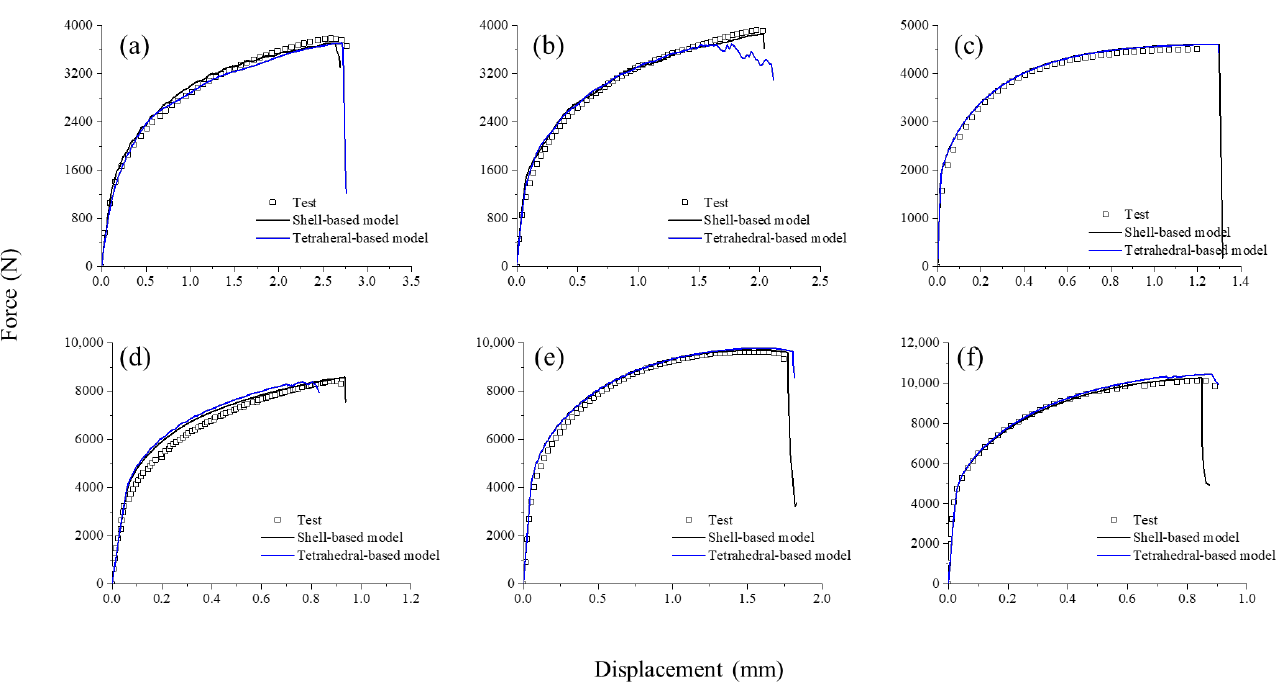
Figure 10. Shell-based model simulation vs. experiments for MAT 1 using GISSMO: ( a ) shear spec- imen, ( b ) tensile – shear specimen, ( c ) tensile specimen, ( d ) center hole specimen, ( e ) R20 notched specimen, and ( f ) R5 notched specimen.